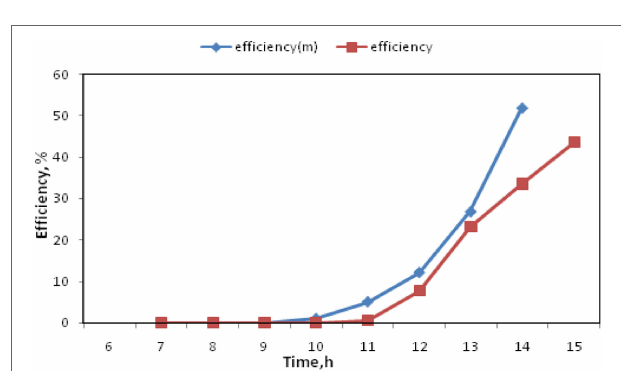
FIGURE 5 | Hourly profile of productivity with solar radiation for modified and conventional solar still.